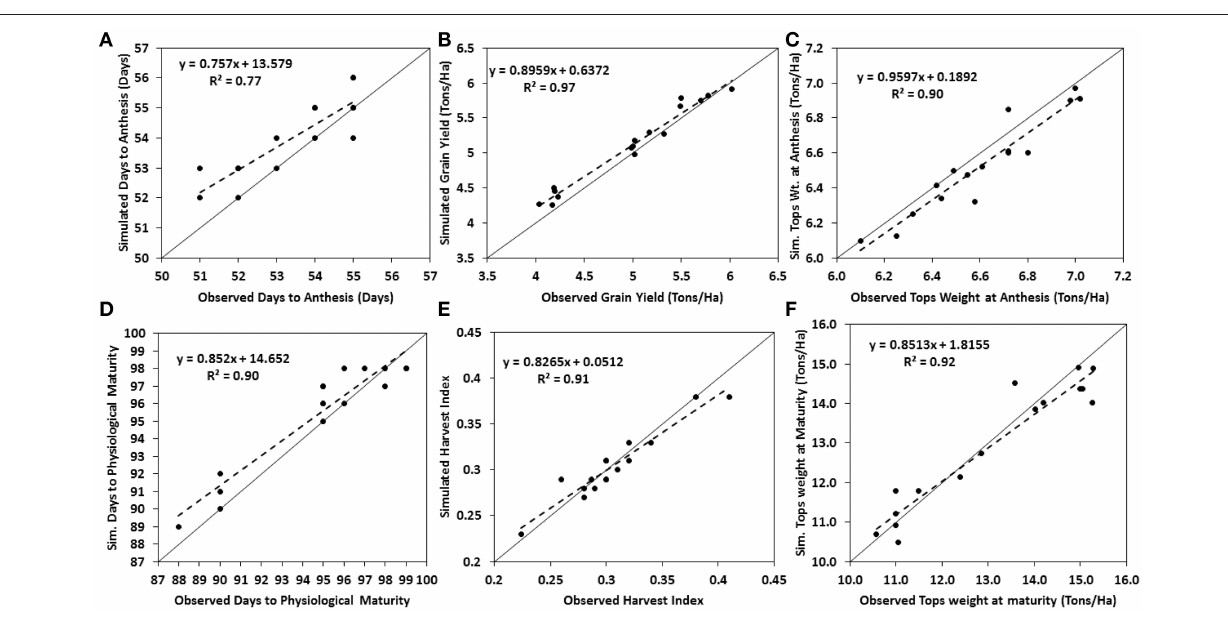
Nigeria is early to mid-June in both SS and NGS (NAERLS,